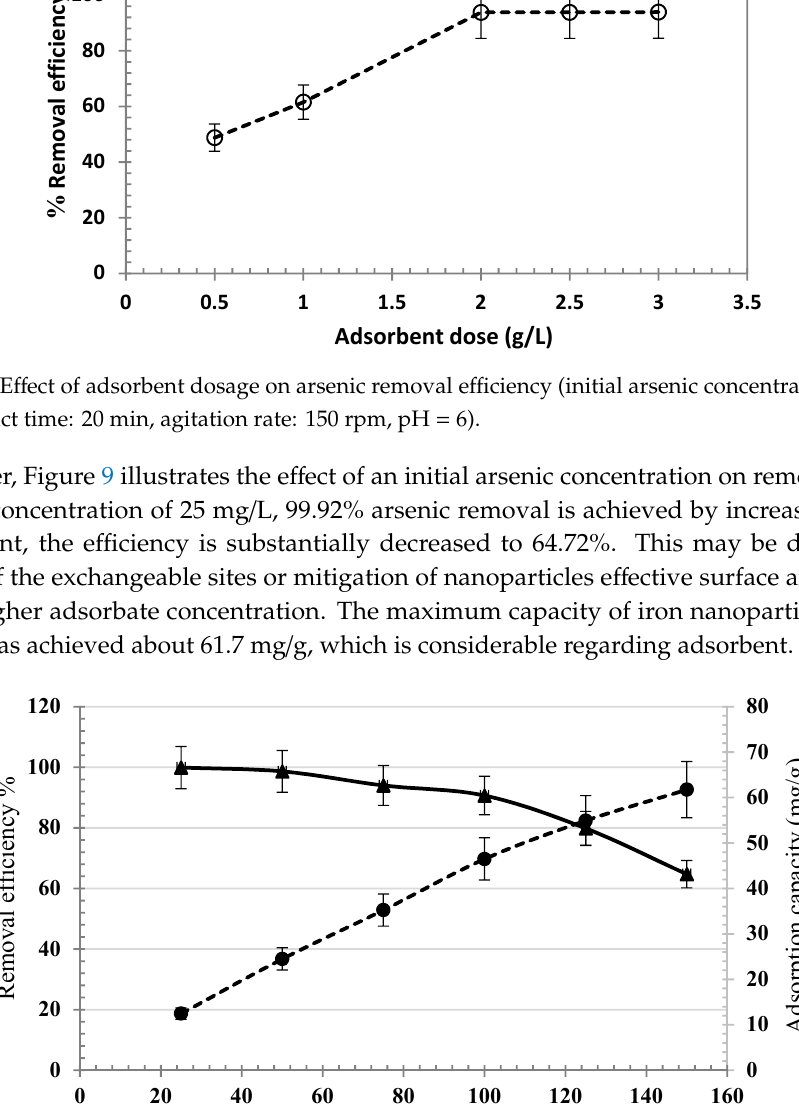
contact time: 20 min, agitation rate: 150 rpm, pH = Figure 9. Effect of initial arsenic concentration on arsenic removal efficiency (sorbent dosage: 2 g/L,